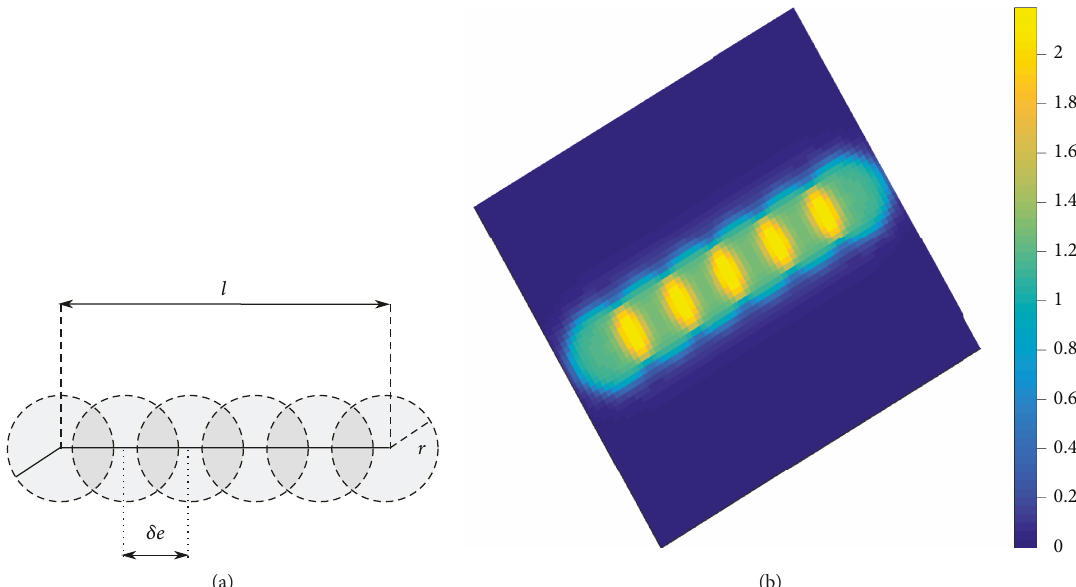
Figure 1: Schematic representation of a stick obtained using point source blobs with centers placed on the linear segment of length l (a); strength fi eld generated by self-blending property (b).